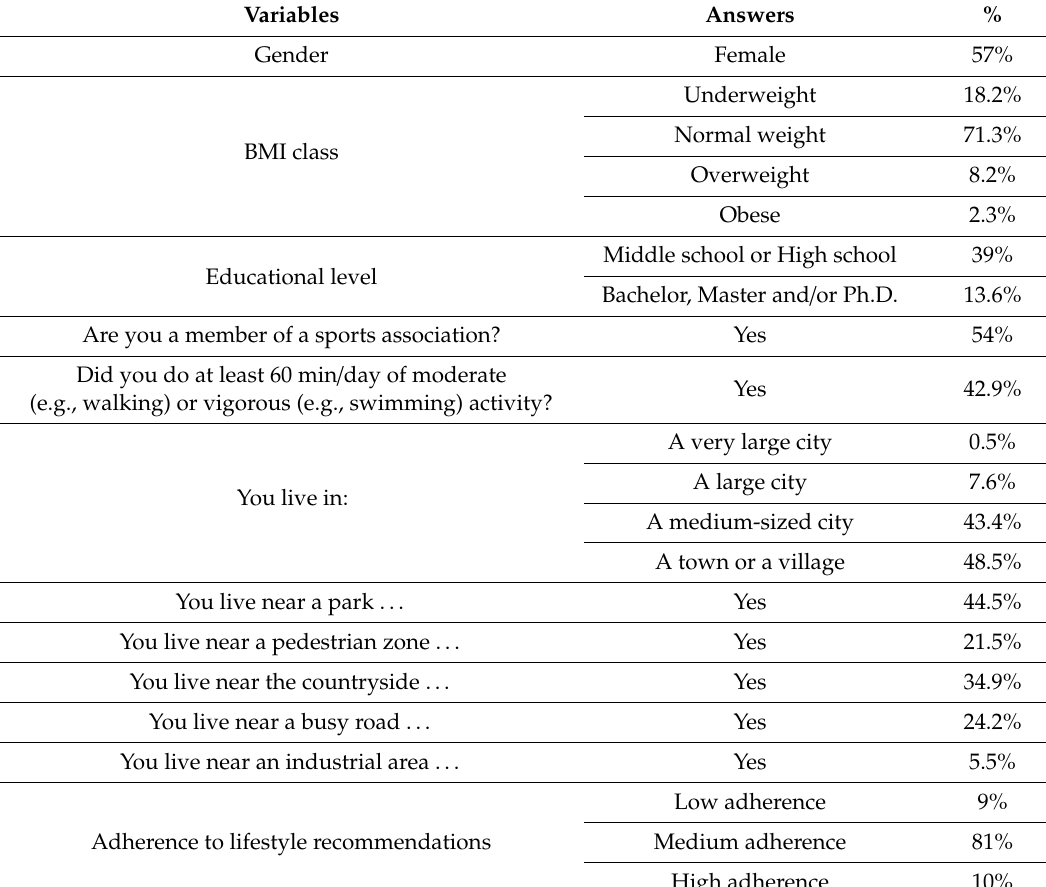
Table A3. Characteristics of respondents.